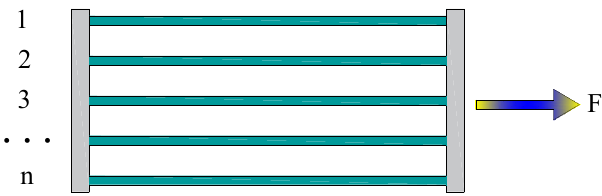
Figure 2. The model diagram fiber bundle strength.